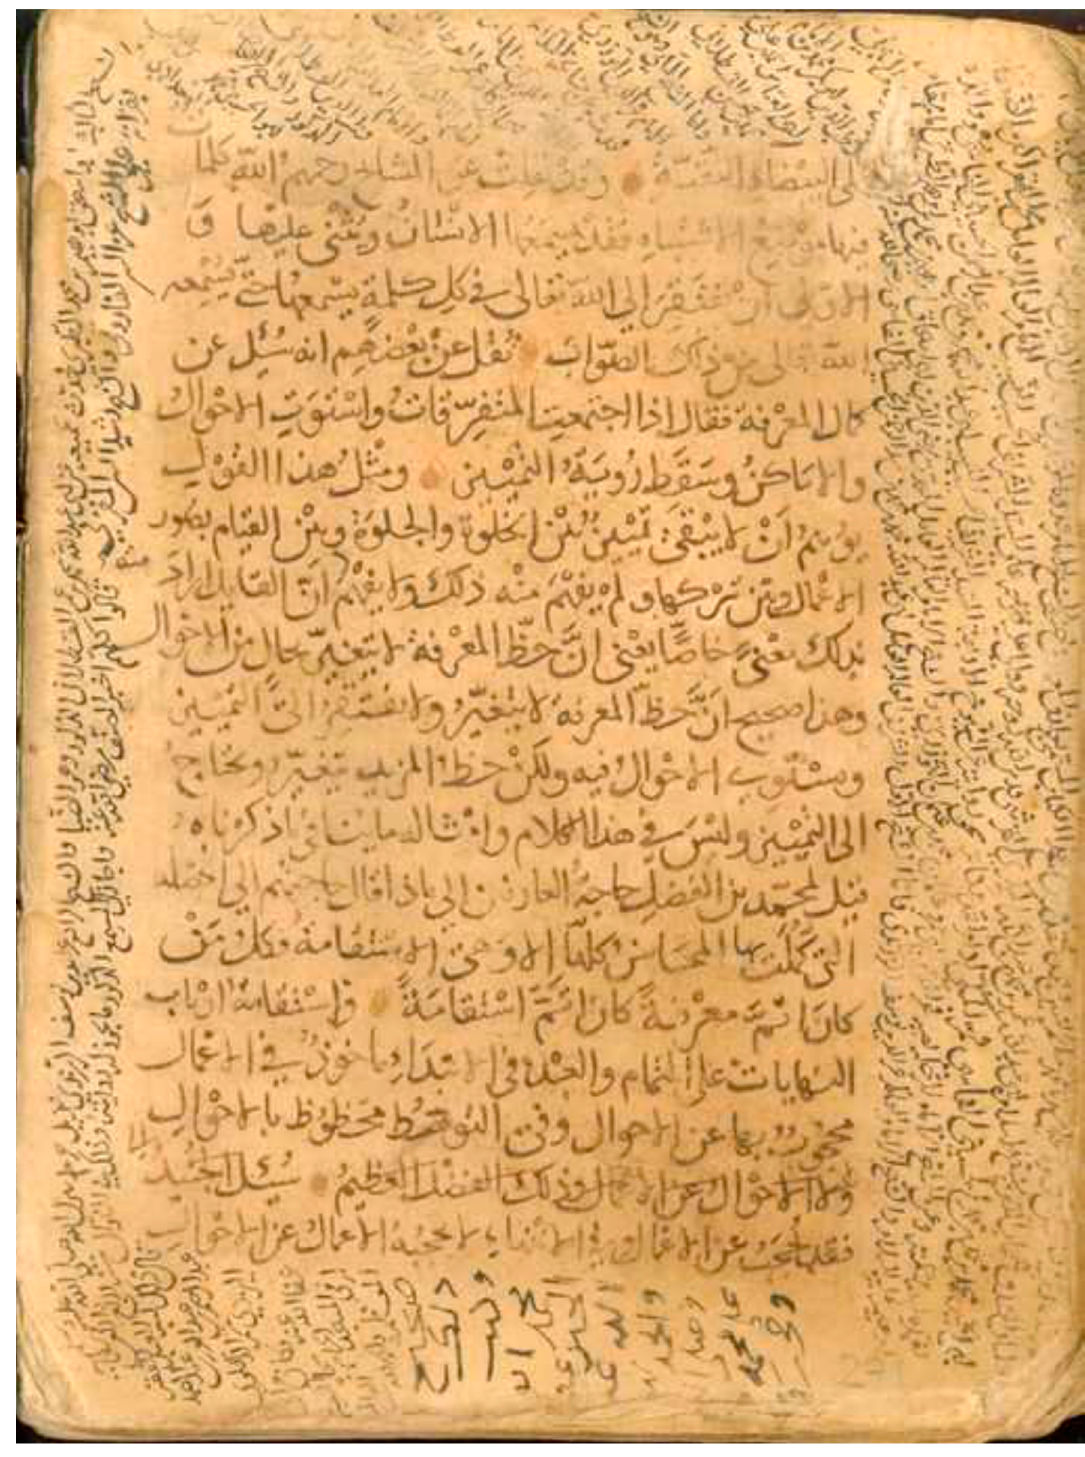
Figure A2. MS Belgrade O.1115, f.263b (audition record on the marginalia and autograph of Ab ū al- Khayr al- Ḥ usayn ī on the bottom margin).